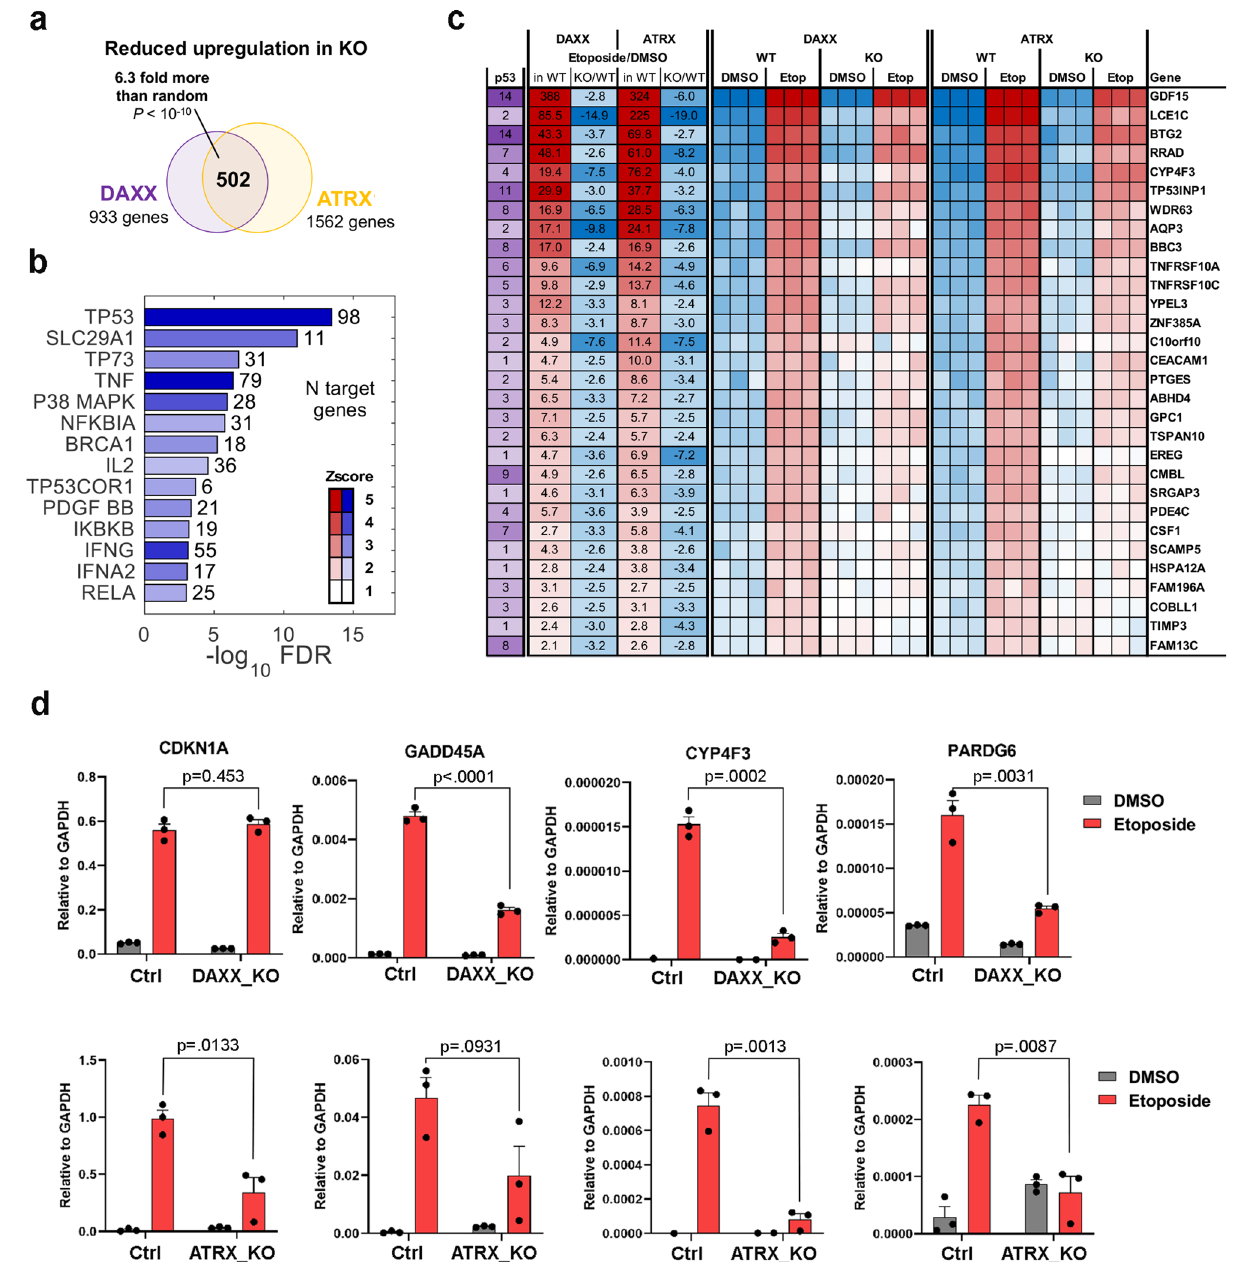
Fig. 3 | Transcriptomic analysis of DNA damaging response in DAXX_KO and ATRX_KOU87cells.a Venndiagramshowingoverlapofgeneswithinhibitedeffect totreatmentwithetoposideinDAXX_KOandATRX_KOrelativetoWTcontrolcells. b Signi fi cantly enriched regulators (FDR<10 − 3 , Z>2) predicted by IPA to have the most inhibited response to etoposide treatment common in both DAXX_KO and ATRX_KOcells. c Expressionheatmapfortop30differentiallyregulatedknownp53 targets showing a reduction in response to etoposide in DAXX_KO and ATRX_KO